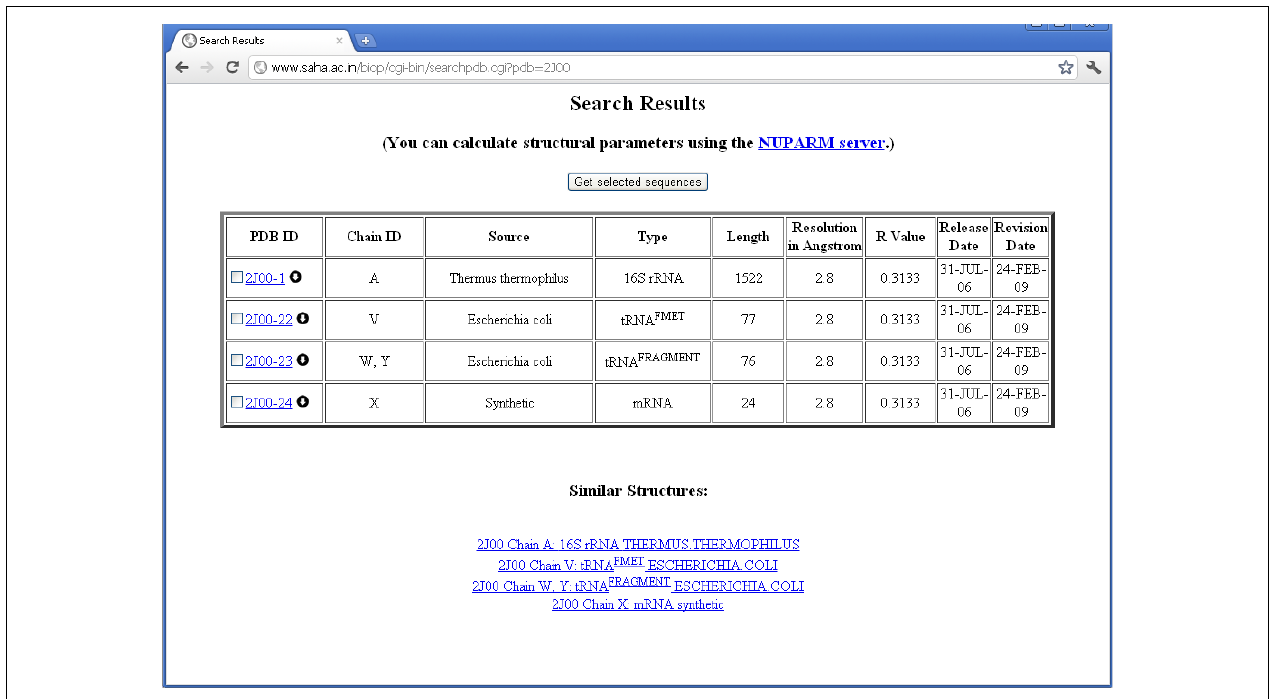
FIGURE 2 | Proper classification of individual RNA chains present in 2J00 in